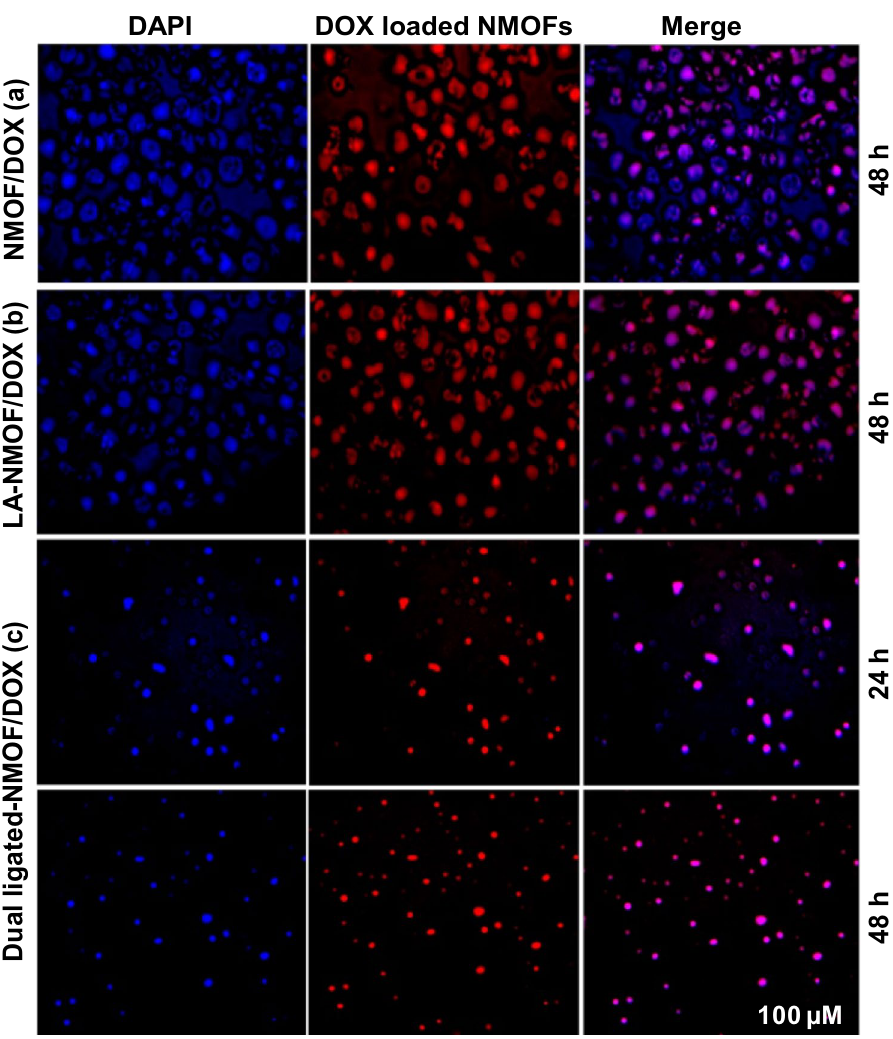
Figure 6. Fluorescence micrographs of HepG2 cell lines treated with ( a ) NMOF-DOX at 48 h. ( b ) LA-NMOF- DOX at 48 h, ( c ) LA-GA-NMOF-DOX at 24 h and 48 h. Scale bar 100 µM and magnification 10